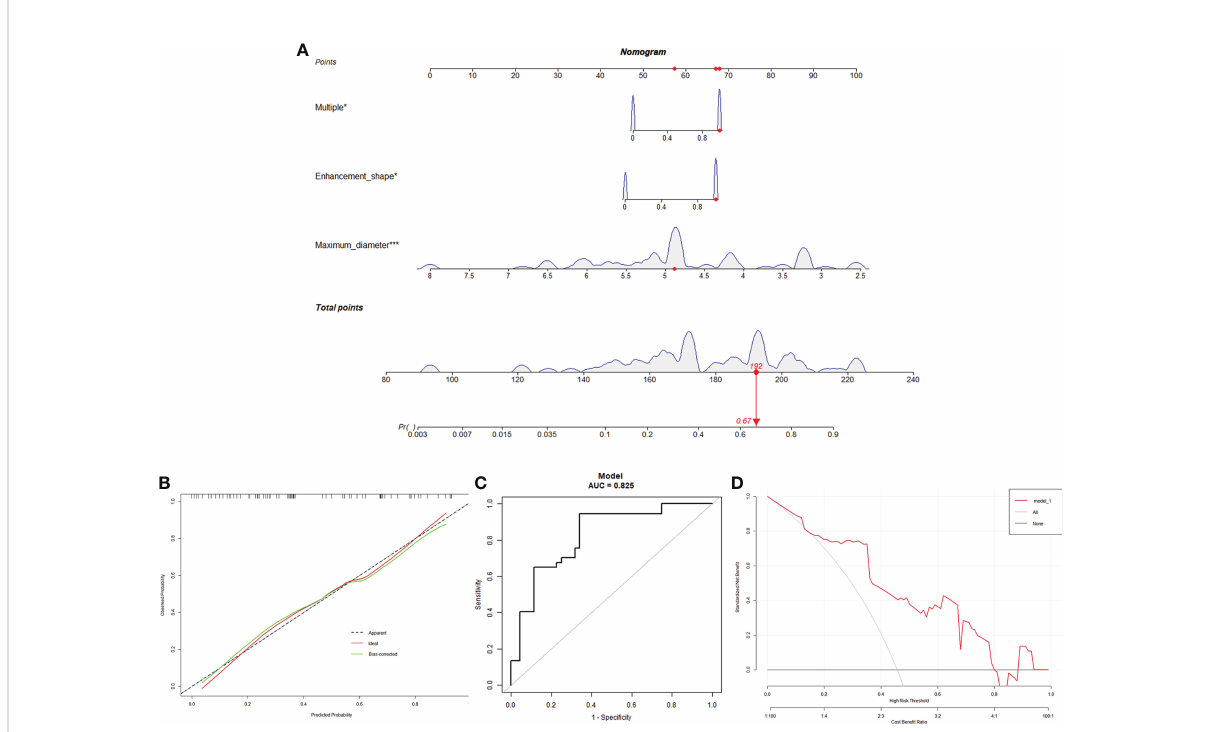
FIGURE 2 A Nomogram for predicting the mutation status of BRAF. (A) : MRI manifestation corresponds to a speci fi c point by drawing a line straight upward to the points axis. After the sum of the points is located on the total points axis, the sum represents the probability of MUT BRAF. (B) : The calibration curve of the model in line with the agreement between predicted and observed outcomes. (C) : ROC curve was made to evaluate the discriminating capability of the nomogram. (D) : The DCA was drawn with the net bene fi t rate as the ordinate and the high-risk threshold as the